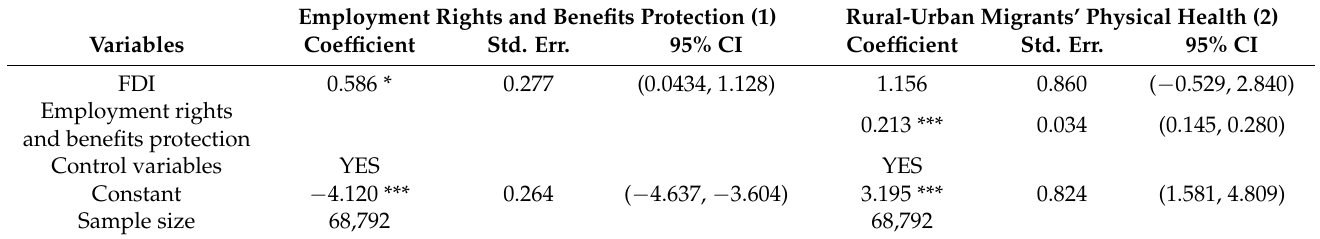
Table 4. Test of intermediary effect of FDI on rural-urban migrants’ physical